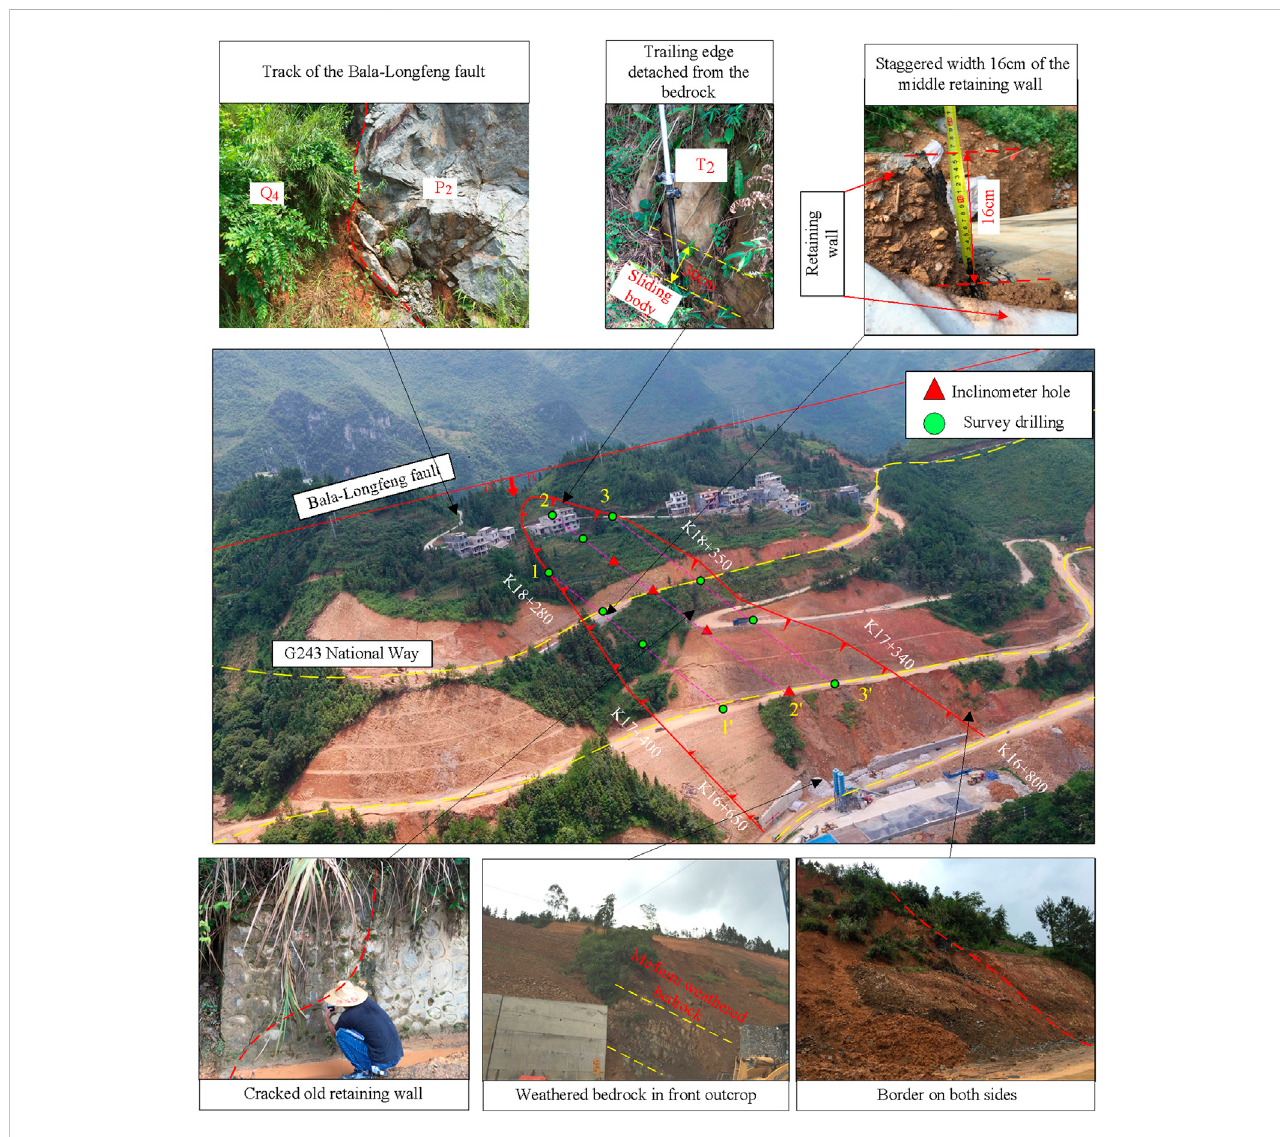
FIGURE 2 Landslide plan and typical damage photos (SE139 ° , August